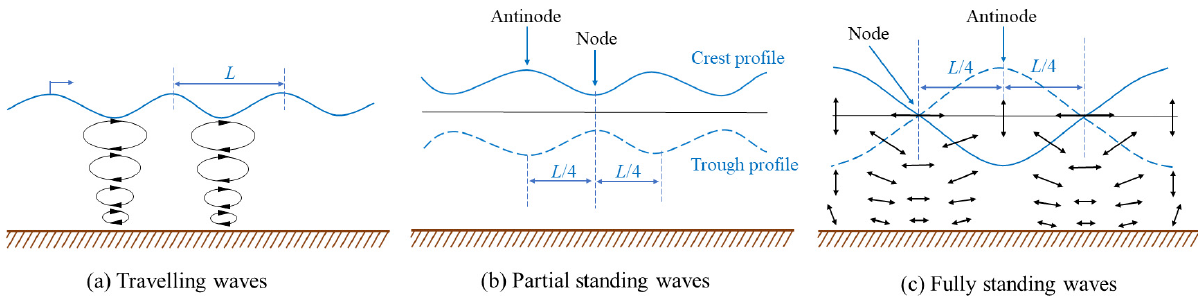
Figure 1. Sketch of the three types of waves.